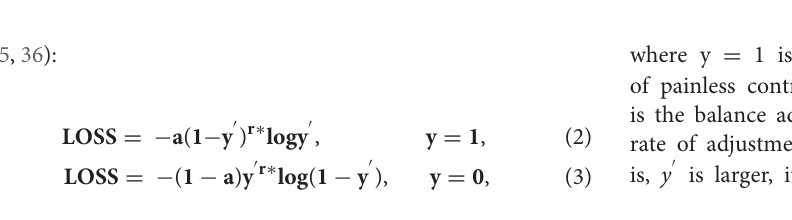
FIGURE 4 | From left to right are the 10-fold cross-validation results of ELM and BP on the running